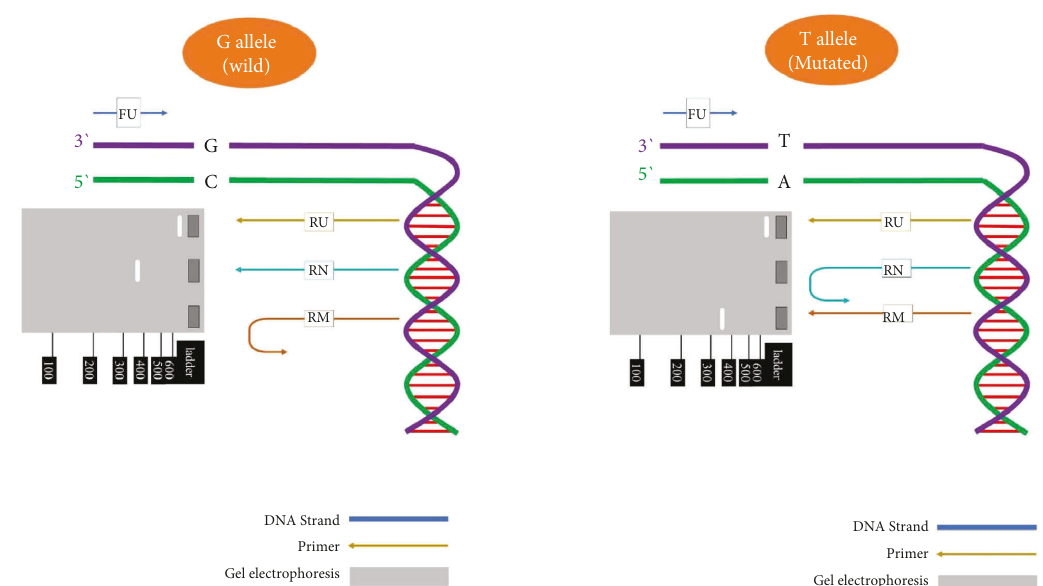
Figure 2: Process of SNP genotyping using Tetra-ARMS-PCR for CYP2B6 ∗ 6 (516G > T) in not-mutated (a) and mutated (b) DNAs.